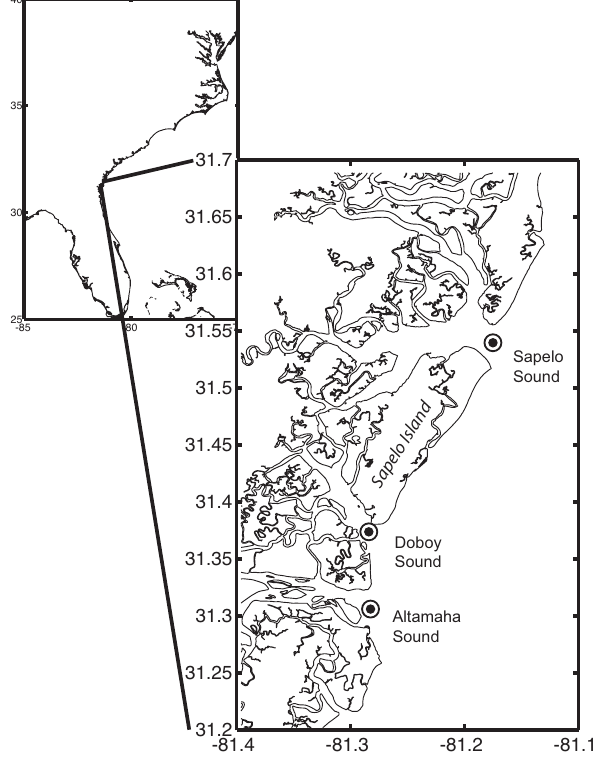
Fig. 1. Sample sites for the seasonal